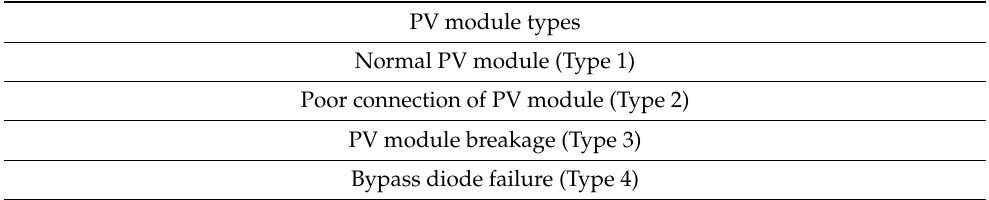
Table 2. The fault-state models of a PV module.